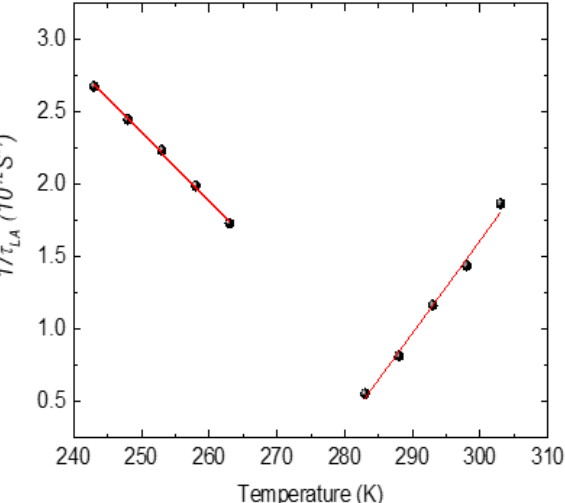
Figure 18. Plot showing 1 / τ LA as a function temperature for the LA phonon of SCT-0.03. The solid line shows the fit of the experimental data points.